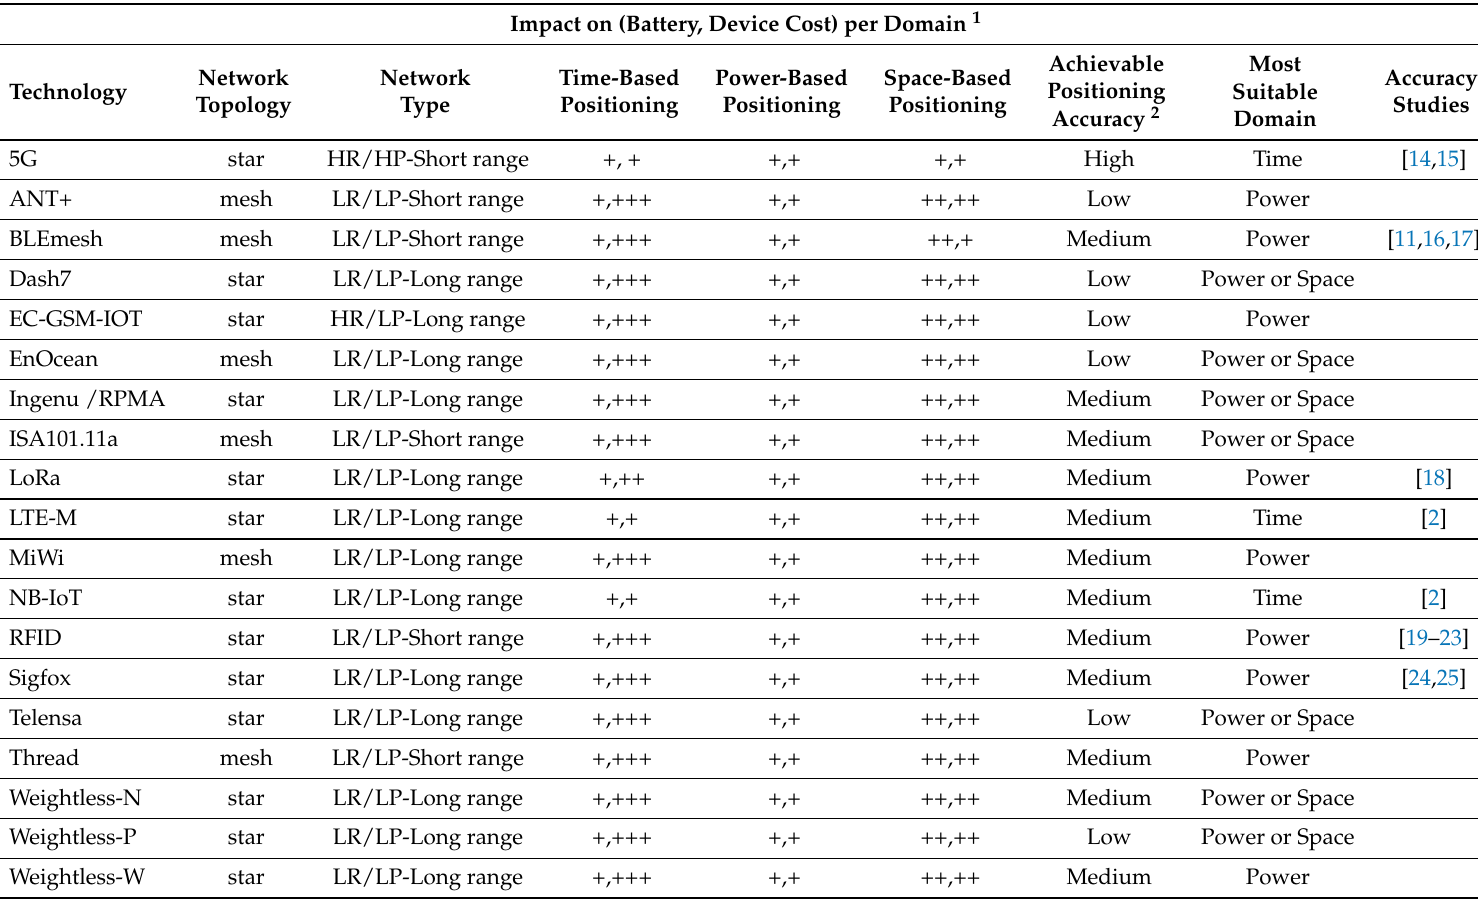
Table 1. Summary of key positioning related aspects for several IoT protocols and IEEE 802.11 ∗ family